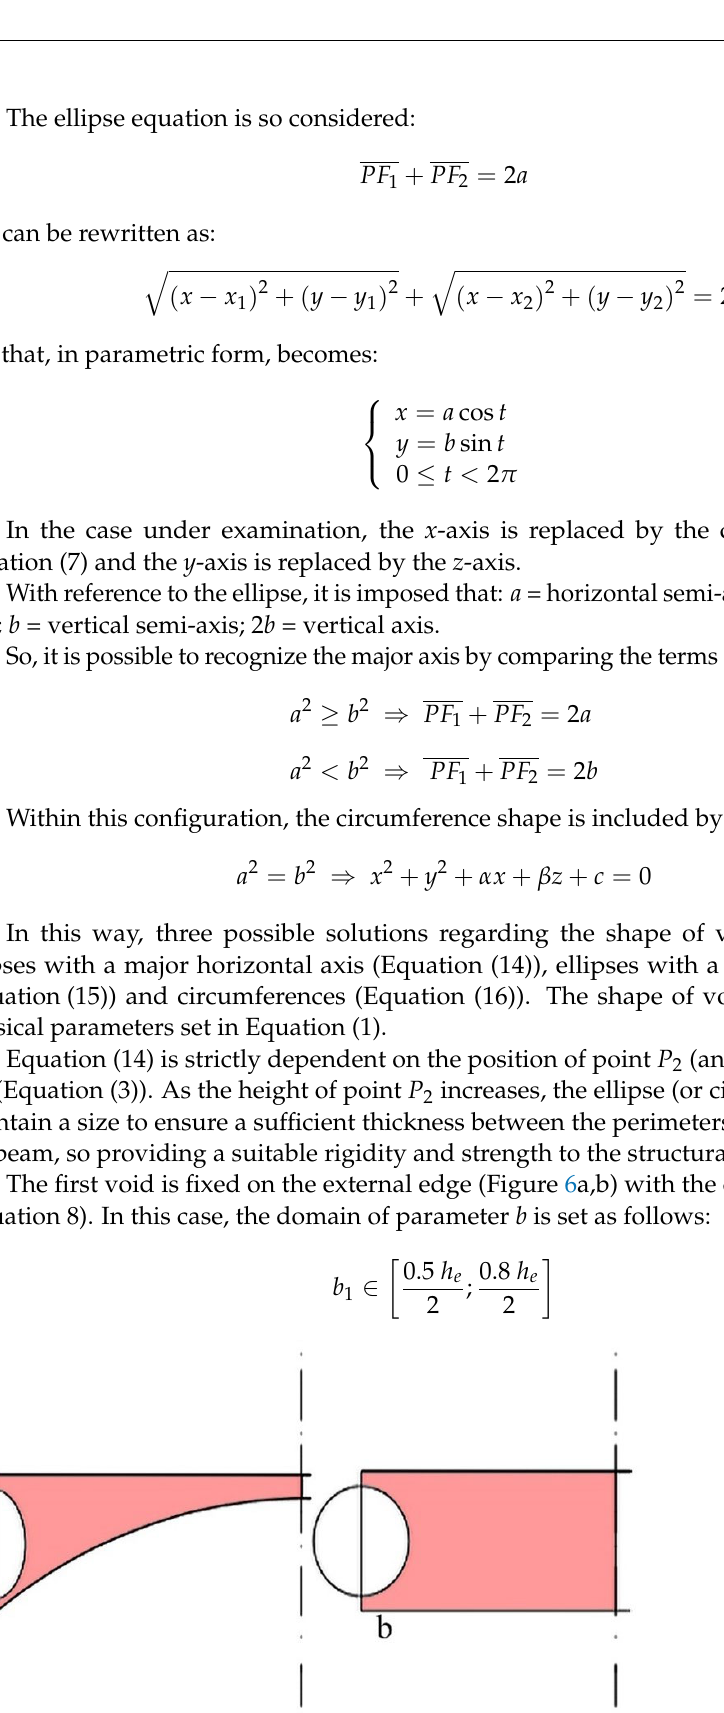
Figure 6. ( a ) Edge void no.1 with h m (cid:48) > 0; ( b ) edge void no.1 with h m (cid:48) =